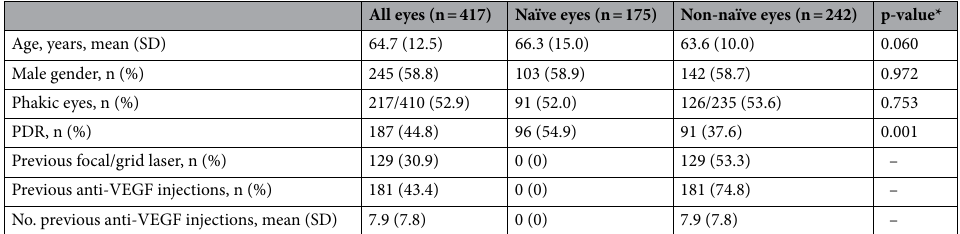
Table 1. Descriptive statistics: demographic data and baseline characteristics. *p value between naïve and non-naïve eyes. Tested by univariable logistic regression analysis, generalized estimating equations model. PDR—Proliferative diabetic retinopathy, SD—Standard deviation, VEGF—Vascular endothelial growth